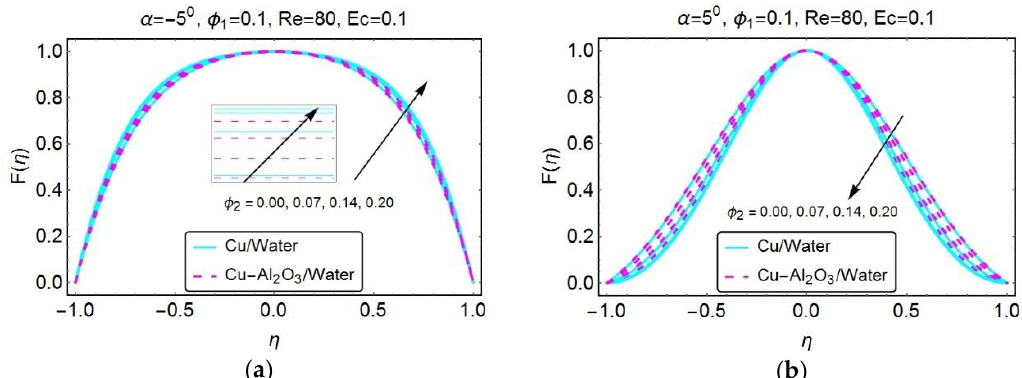
Figure 4. Stimulus of φ 2 on F( η ) : ( a ) convergent case and ( b ) divergent channel.